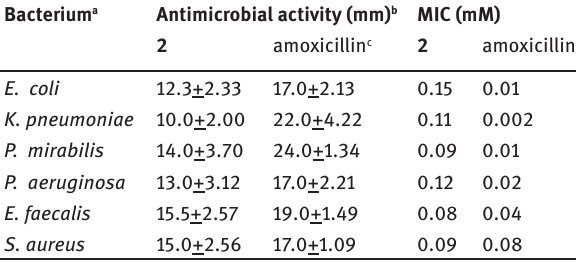
a E. coli, K. pneumonia, P. mirabilis and P. aeuroginosa are